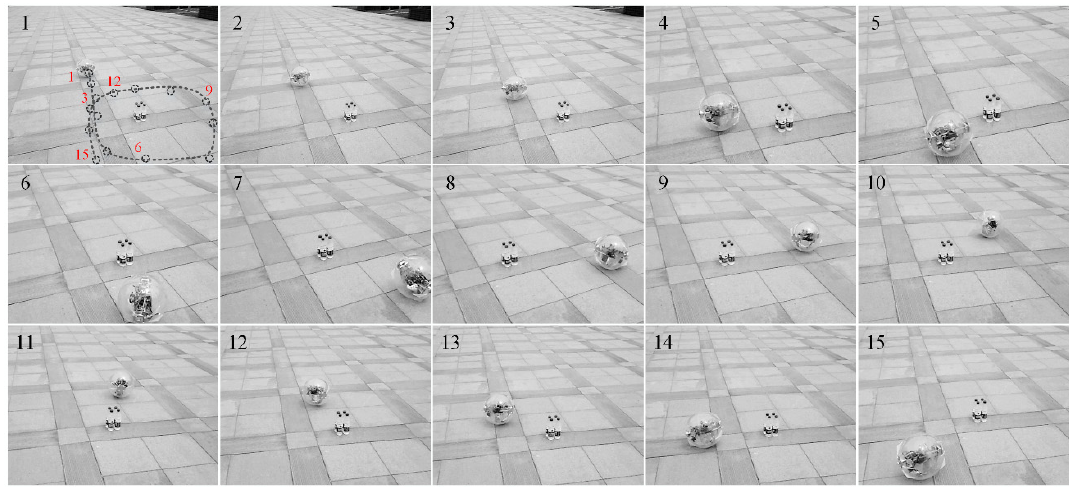
Figure 10. Curvilinear motion on land.